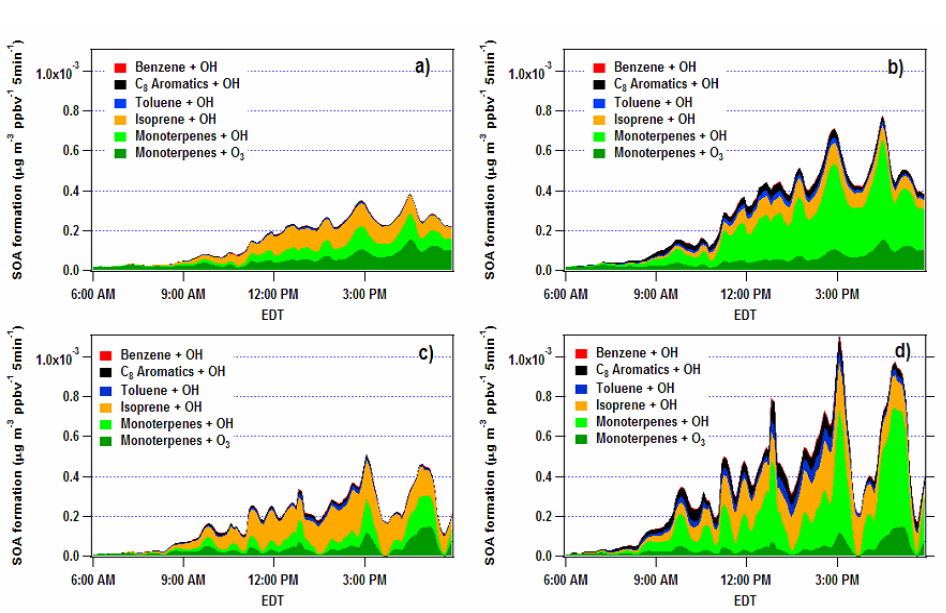
Fig. 10. Amounts of SOA formed per unit time and colored by precursor and oxidant, as calculated using the methods described in the text. Figure 10. Amounts of SOA formed per unit time and colored by precursor and oxidant, (a) Full campaign, high NO x , (b) full campaign, low NO x , (c) Detroit air, high NO x , (d) Detroit air, low NO x . All data have been normalized as calculated using the methods described in the text. a: Full campaign, high NO x , b: Full to